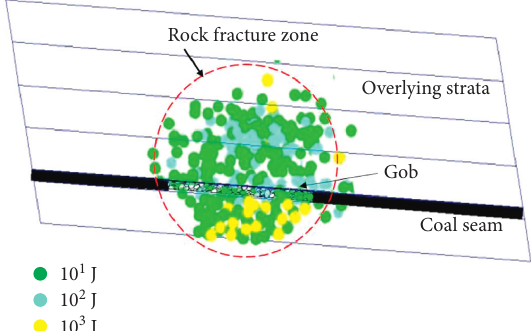
Figure 6: Fracture development in roof and floor of the coal seam after LW 1300 was mined.